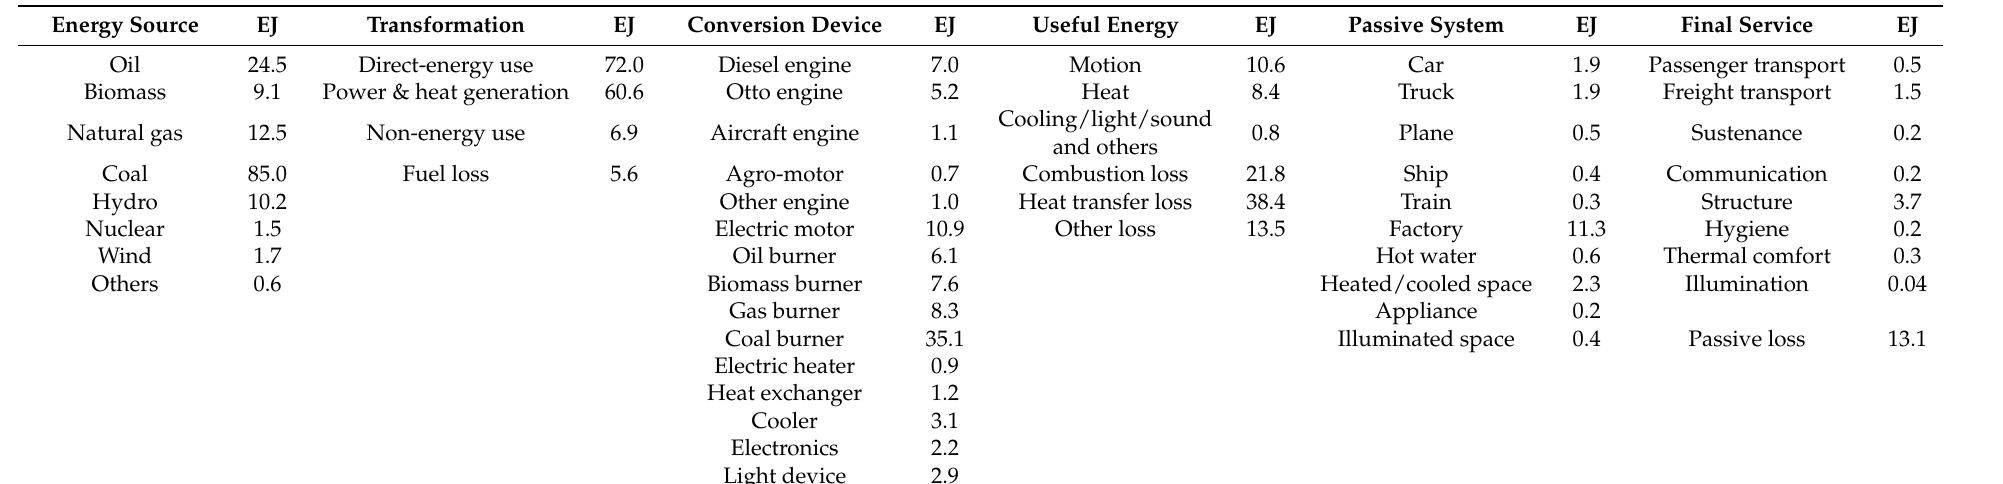
Table A3. Vertical slices of exergy flow of China in